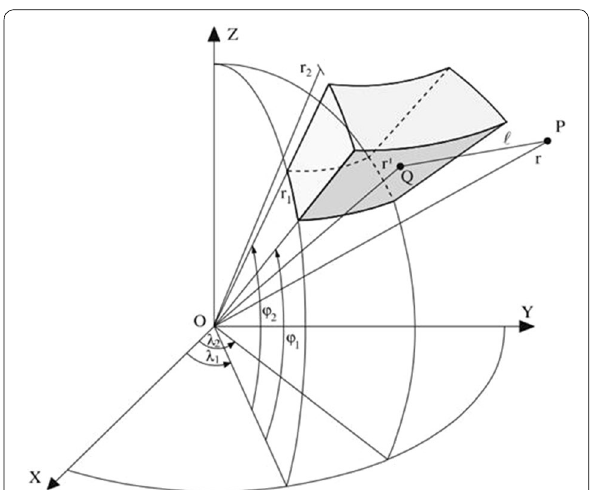
Fig. 1 Geometry of the tesseroid (Heck and Seitz 2006), point O is the original point of the SCS; r 1 and r 2 , λ 1 and λ 2 , as well as ϕ 1 and ϕ 2 are the boundaries in radial, longitude, and latitude directions, respec- tively. Point Q here denotes the geometric center of the tesseroid, and point P is an observation data